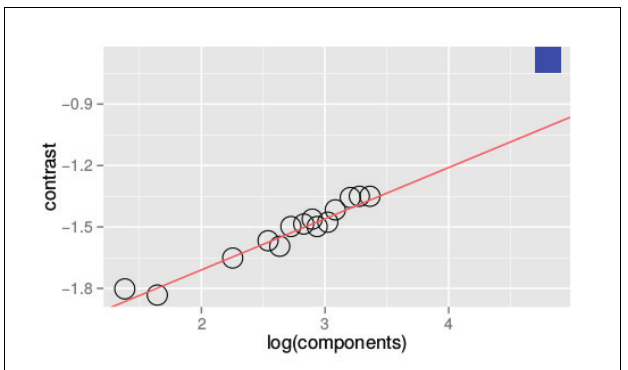
FIGURE 3 | Threshold vs. bandwidth data re-plotted from Figure 1. Each symbol represents the average threshold from three observers and the blue square represents the average threshold for detecting unfiltered white noise.Theredlineisthebestfittingpowerfunctionwithaquarter-rootslope; the fit was done excluding the threshold measured with white